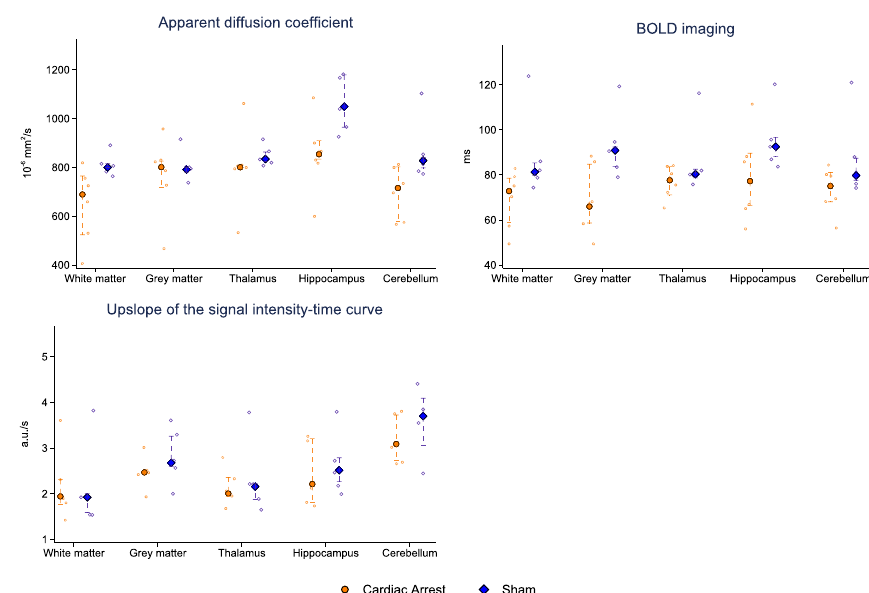
Fig. 5 Apparent diffusion coefficient values, blood oxygenation level dependent (BOLD) imaging, and upslope of signal intensity curve of perfusion-weighted imaging in five different anatomical locations in the brain. Data are presented as median [25–75%] with overlaid scatter plots representing each animal. Ms milliseconds, a.u. arbitrary unit